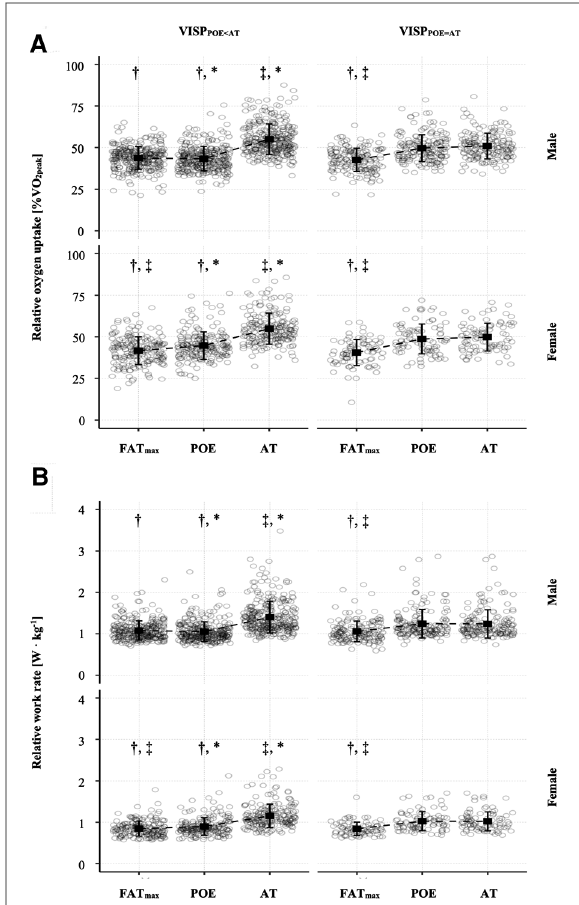
FIGURE 3 Means (squares)±standard deviations (lines) of the relative oxygen uptake ( A ) and the relative work rate ( B ) at the ventilatory indices Fat max , POE and AT in VISP POE<AT and VISP POE=AT , shown for females and males separately. The dots refer to individual values at the different ventilatory indices. Additionally, adjusted p -values of post-hoc comparisons between ventilatory indices and VISP groups are displayed: † p <.05 vs. AT; ‡ p <.05 vs. POE; * p <.05 vs. VISP POE=AT .